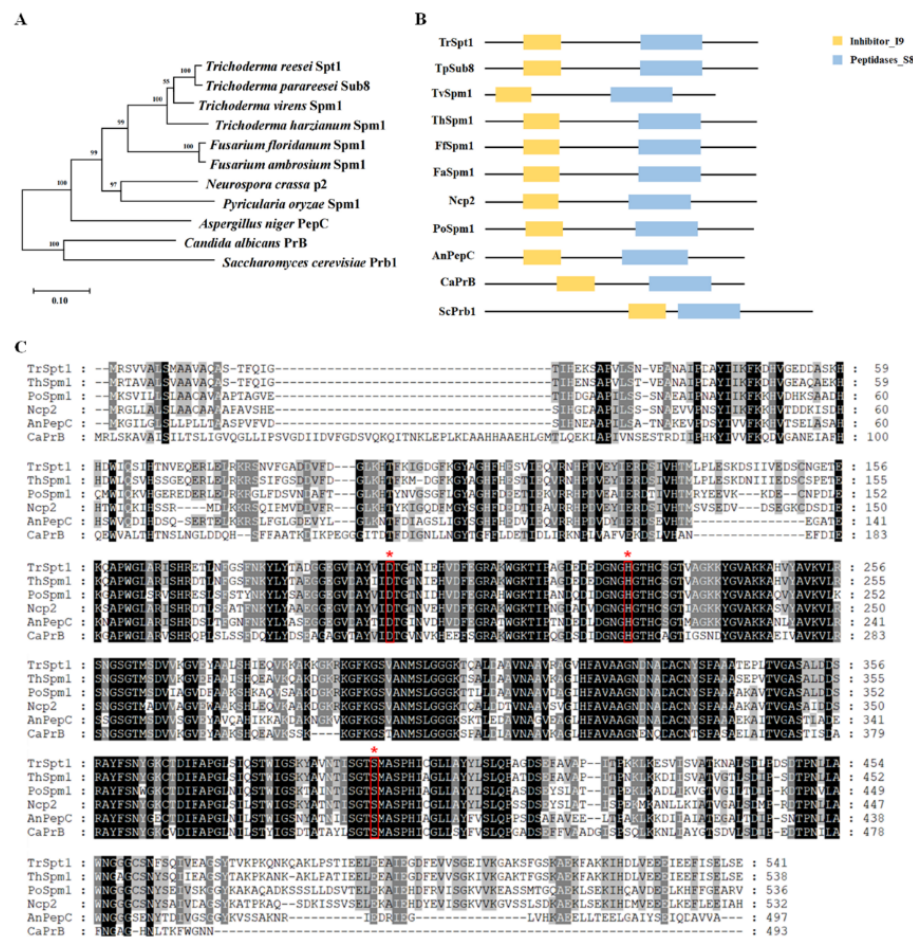
Figure 1. Sequence and phylogenetic analysis of T. reesei Spt1 and its homologs in fungi. ( A ) Phylo- genetic tree of Spt1 homologs in various fungal species. The sequence alignments were performed using the Clustal W program, and the phylogenetic tree was constructed using a neighbor-joining tree, with a bootstrap method of 1000 replications, in the MEGA 6 program. The numbers represent bootstrap values. The scale bar denotes 0.01 changes per nucleotide position. ( B ) Diagram for the domain architecture of Spt1 homologs. These proteins contain an inhibitor I9 domain (yellow box) and a peptidase S8 domain (blue box). ( C ) Alignment of the amino acid sequence of Spt1 with related fungal sequences. The high-identity regions in the amino acid sequence are indicated with black backgrounds. The red boxes indicate the active sites for the serine protease belonging to the subtilisin family. * indicate that where the active sites for the serine protease are located. The sequence